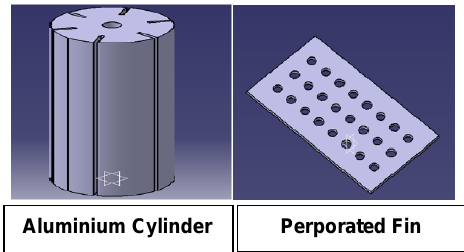
Figure7: 3D Image of aluminium cylinder and perporated fin [60]